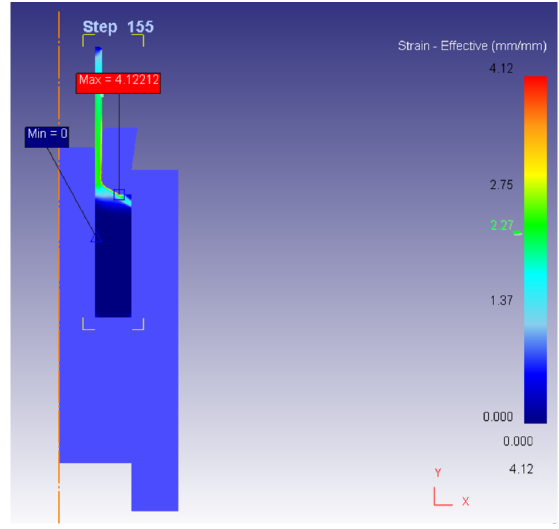
Figure 15. Effective Strain during extrusion process.